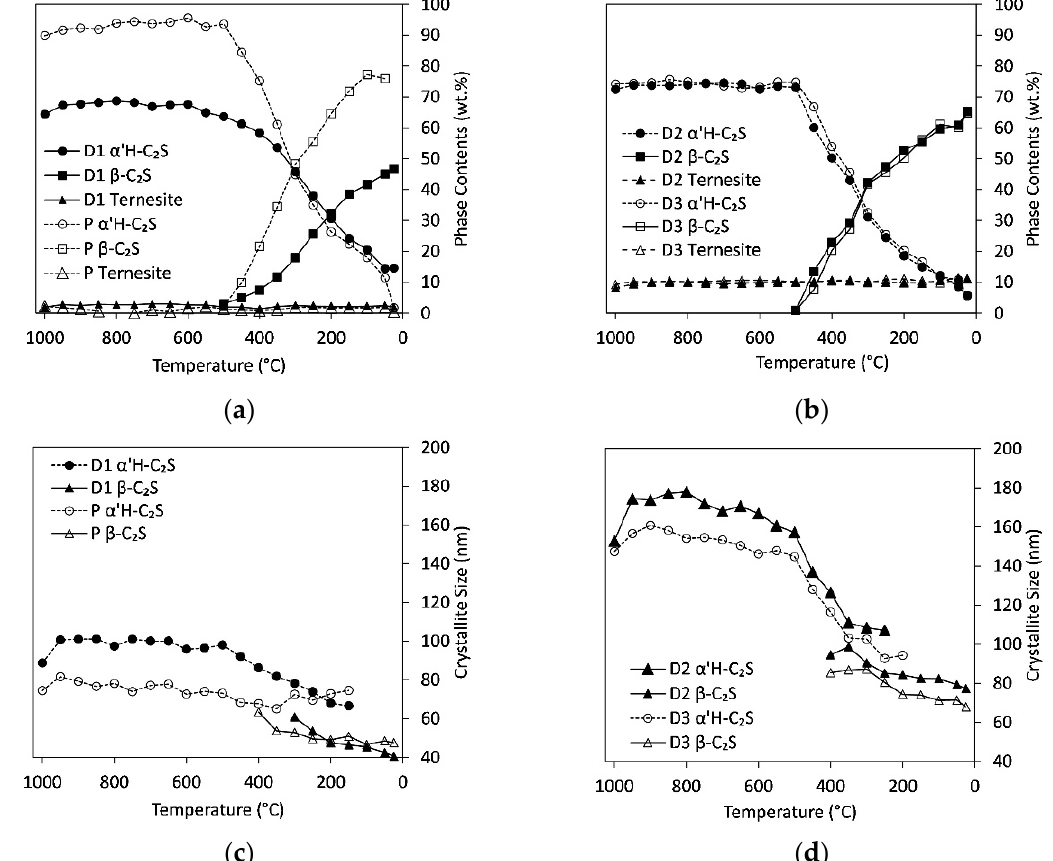
Figure 4. Cooling of autoclaved aerated concrete with calcite (C/S = 2, step50). Phase contents of α ’H-C 2 S, β -C 2 S, and ternesite for samples D1 and P ( a ) and D2 and D3 ( b ), respectively. Crystallite sizes for α ’H-C 2 S and β -C 2 S with phase contents >20 wt.% for samples D1 and P ( c ) and D2 and D3 ( d ), respectively.